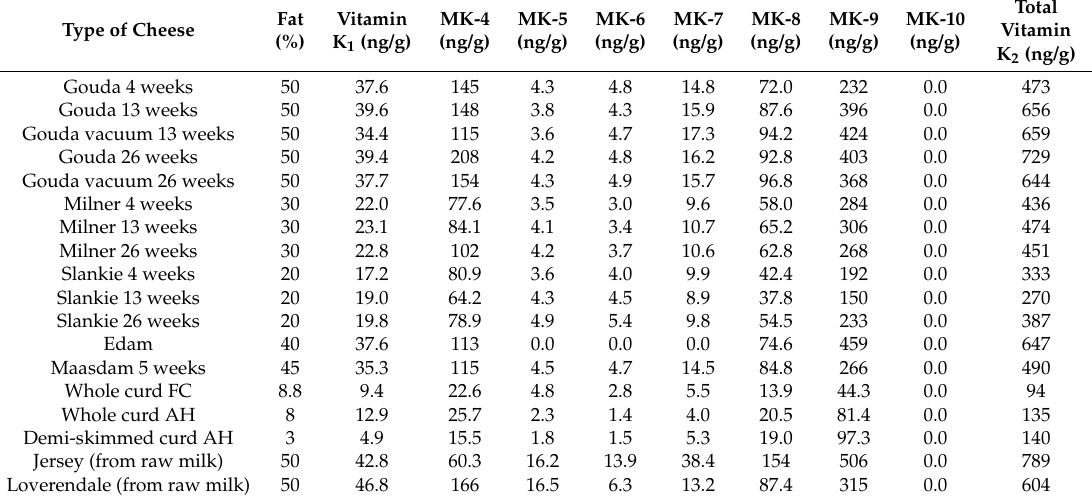
Table 1. Vitamin K content of Dutch cheeses. The most popular cheese is Gouda after 13 weeks of ripening. Milner is a comparable cheese with lower fat content and Slankie is a very low fat product line. Raw milk cheese was produced at local farms; the curds were from brands Albert Heijn (AH) and Friesland Campina (FC). Fat content of cheeses is given as % dry weight; fat content of curds is given as grams per 100